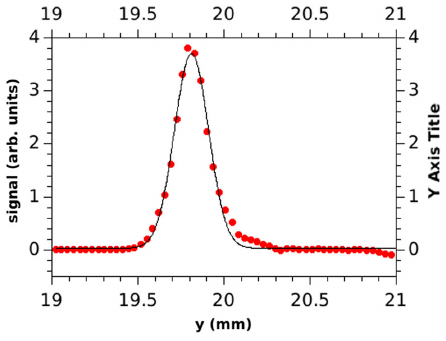
FIG. 4. Measured vertical profile at the